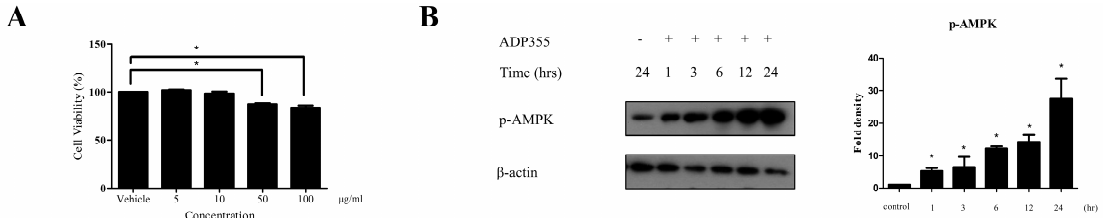
Figure 1. Viability of keloid fibroblasts was evaluated at adiponectin-based peptide (ADP355) doses ranging from 5 to 100 µ g / mL. ADP355 a ff ected cell viability significantly at doses ≥ 50 µ g / mL ( A , p ≤ 0.05, cut-o ff > 90%). At 10 µ g / mL, ADP355 increased the activation of the AMP-activated protein kinase (AMPK) pathway in a time-dependent manner from 1 to 24 h ( B , * p ≤ 0.05). The data are expressed as mean ± SD. Representative data are shown from three independent